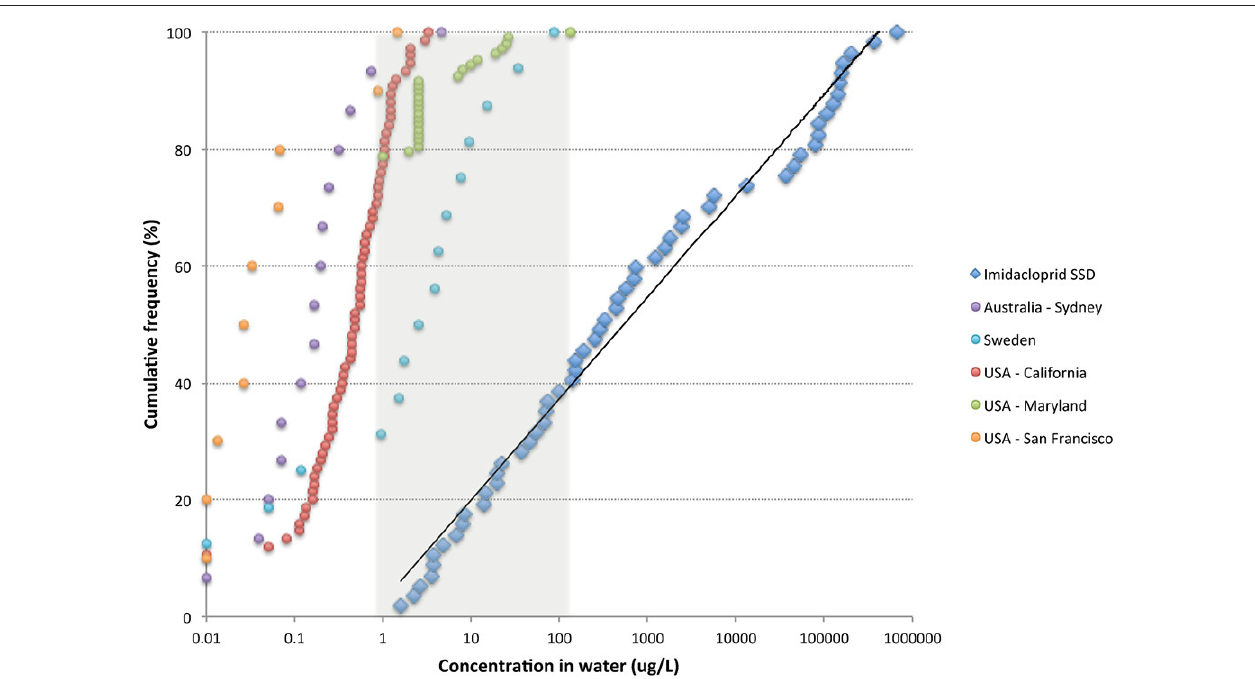
FIGURE 5 | Distribution of waterborne residues of imidacloprid in several countries contrasted with the acute SSD for this compound. Data sources: Australia ( Sánchez-Bayo and Hyne, 2014); Sweden (Kreuger et al., 2010); USA California (Starner and Goh, 2012); USA Maryland (Johnson and Pettis, 2014); USA San Francisco (Weston et al.,